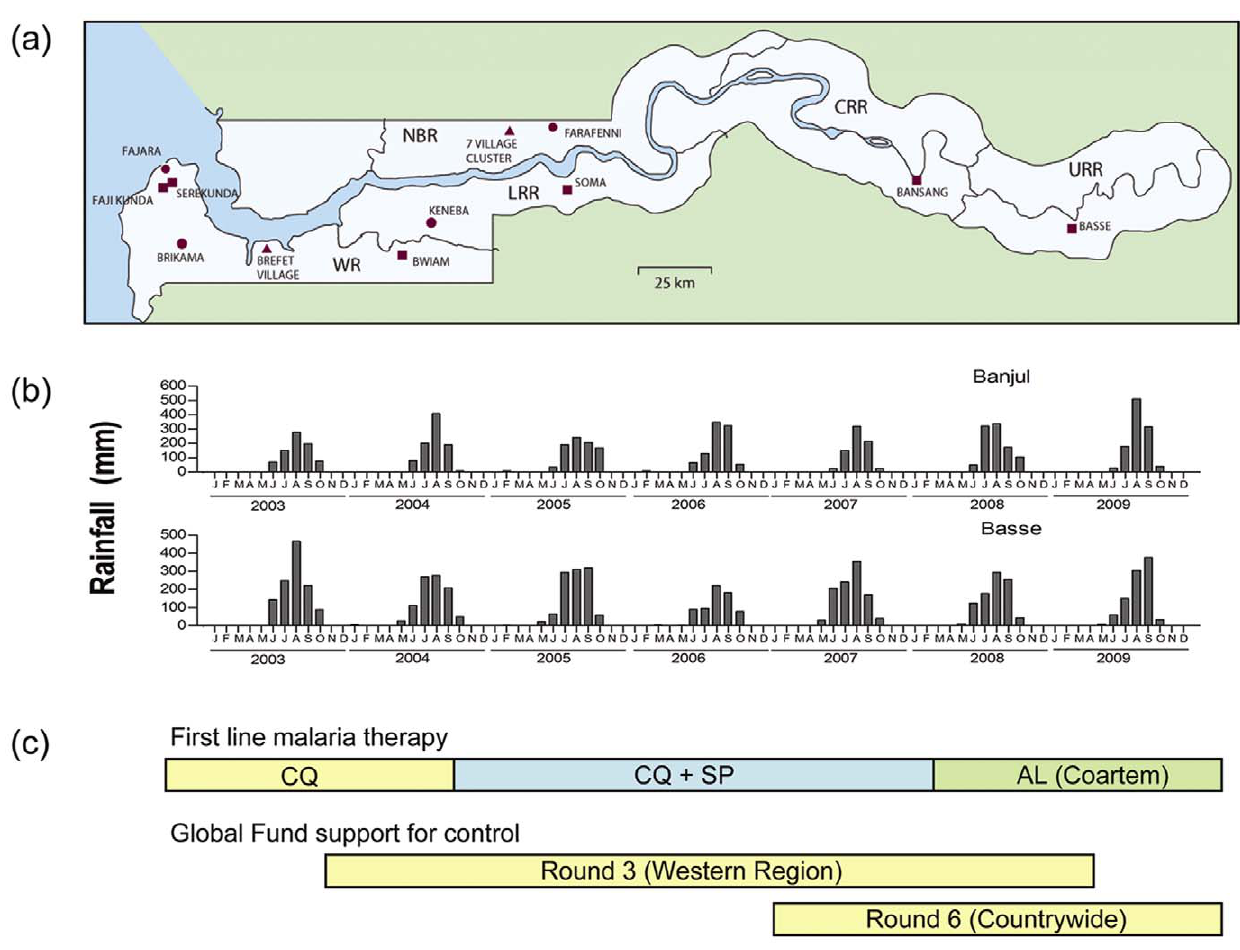
Figure 1. Location of health facilities and populations surveyed, rainfall patterns and Global Fund support for malaria control from 2003 to 2009 in The Gambia. (a) Sites of 10 health facilities at which laboratory slide data were analysed (circular symbols indicate 4 sites previously studied until the end of 2007, square symbols indicate 6 sites not previously studied); sites of the Farafenni village cluster and Brefet village are marked with triangular symbols. (b) Monthly rainfall for two sites at opposite ends of the country (Banjul at the coast in the west and Basse in the east) over the 7 year period. (c) Changes in first-line antimalarial therapy and Global Fund support for malaria control over the period. First-line therapy: CQ, Chloroquine; SP, Sulphadoxine-Pyrimethamine; AL, Artemether-Lumefantrine. The Global Fund has supported Insecticide treated bednet (ITN) provision for children 5 years of age and pregnant women, and intermittent preventative treatment with SP during pregnancy (IPTp) under Round 3 from 2004 onwards (Western Region) and Round 6 from 2007 onwards (countrywide), as well as the purchase of AL (Coartem) to allow free treatment with an effective artemisinin-based combination therapy from 2008 onwards. Coverage of interventions countrywide by the midpoint year (2006) reached 50% for ITN use by children under 5 years of age and 30% for receipt of at least 2 doses of IPTp [35].